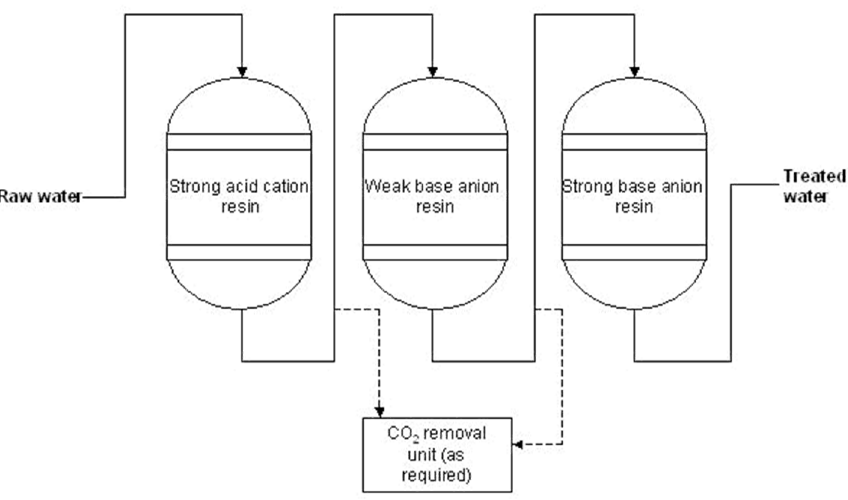
Figure 3. Demineralization technology—Ion exchange units by Lenntech company [9,13]. Table 2. ( a , b) Consumption of chemicals by IX (ion exhchange) technology in the Liberec Heating Station (first half of 2010). RW–raw water, DEMI–outlet of